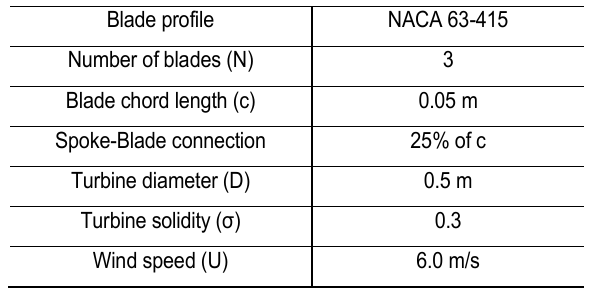
Table 1. Details of the VAWT geometrical